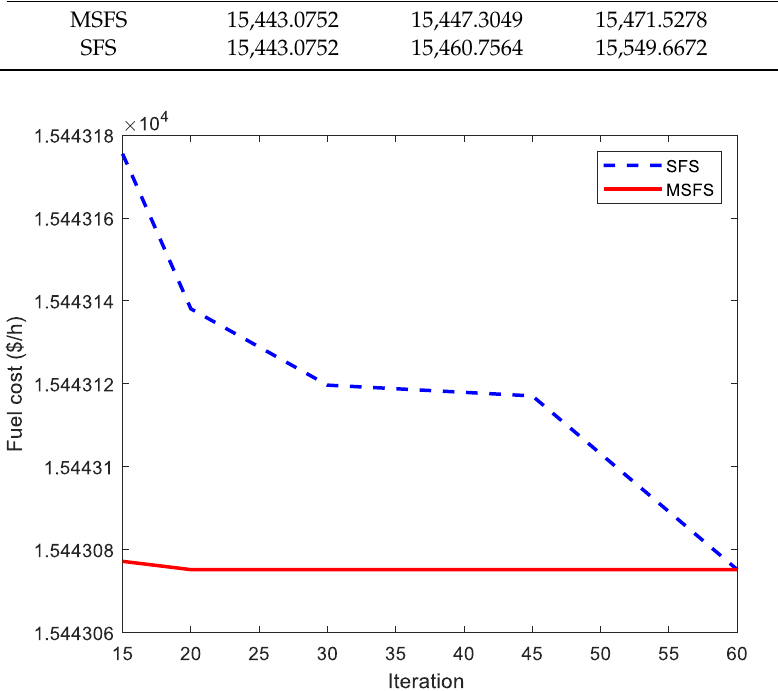
Figure 6. Fuel cost obtained by SFS and MSFS with different values of N Iter for case 6.